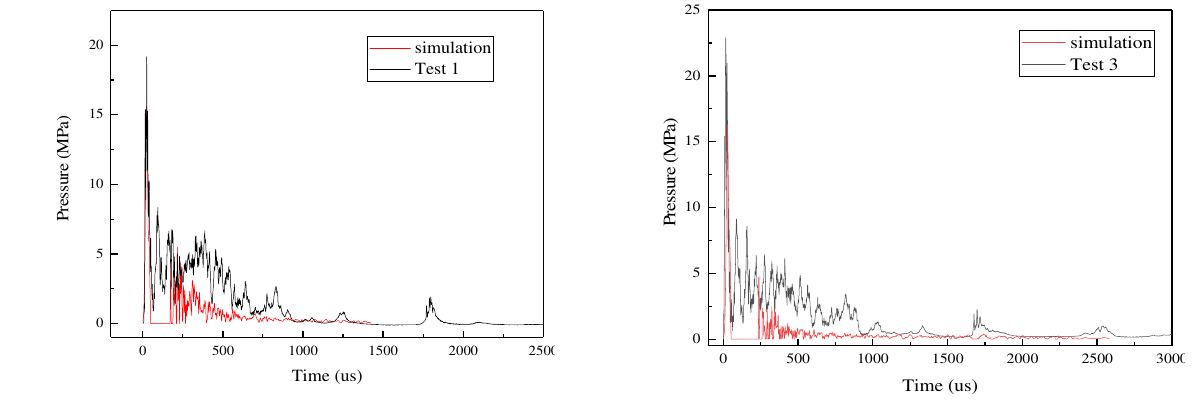
Table 5. Comparison between experimental and calculated residual mass of the projectile. Figure 6. Comparison of experimental and simulated loads. Figure 6. Comparison of experimental and simulated loads.